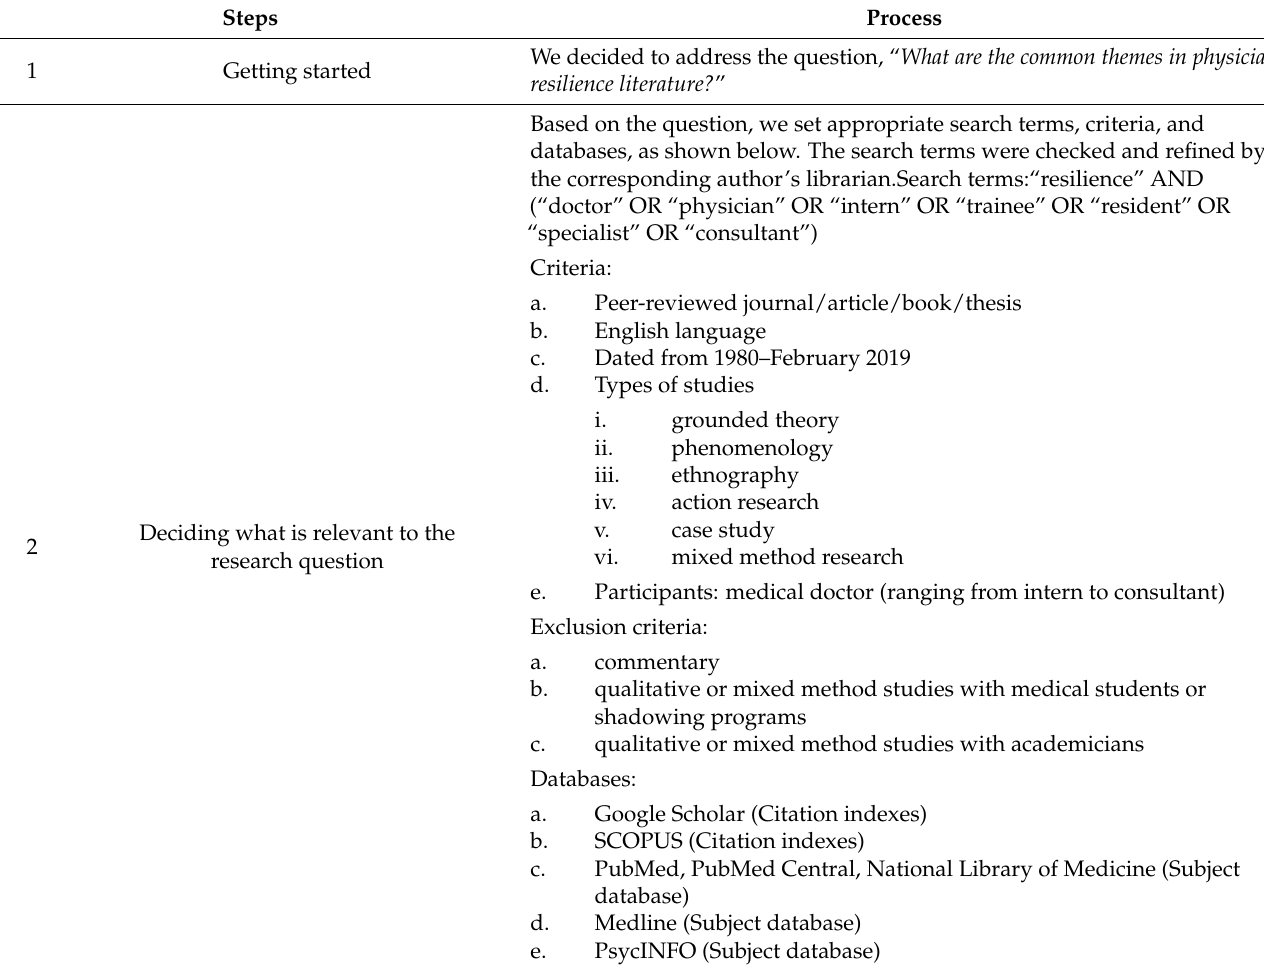
Table 1. Seven-step process used in the meta-ethnography method